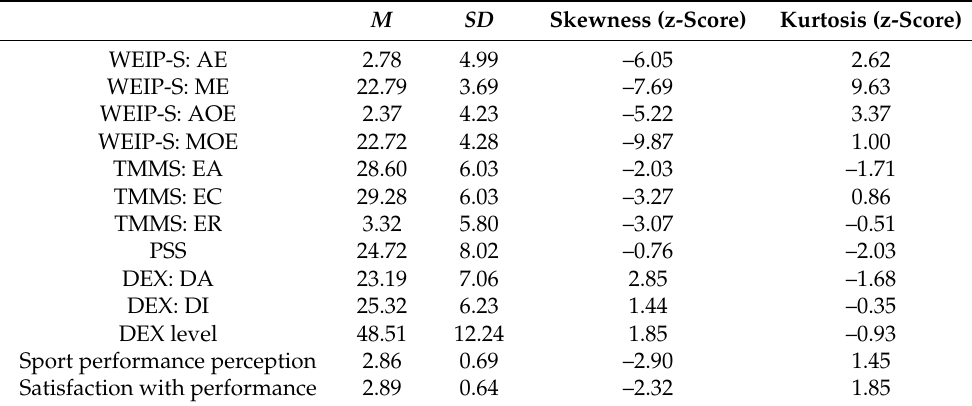
Table 2. Descriptive statistics for psychological tests and self-reported